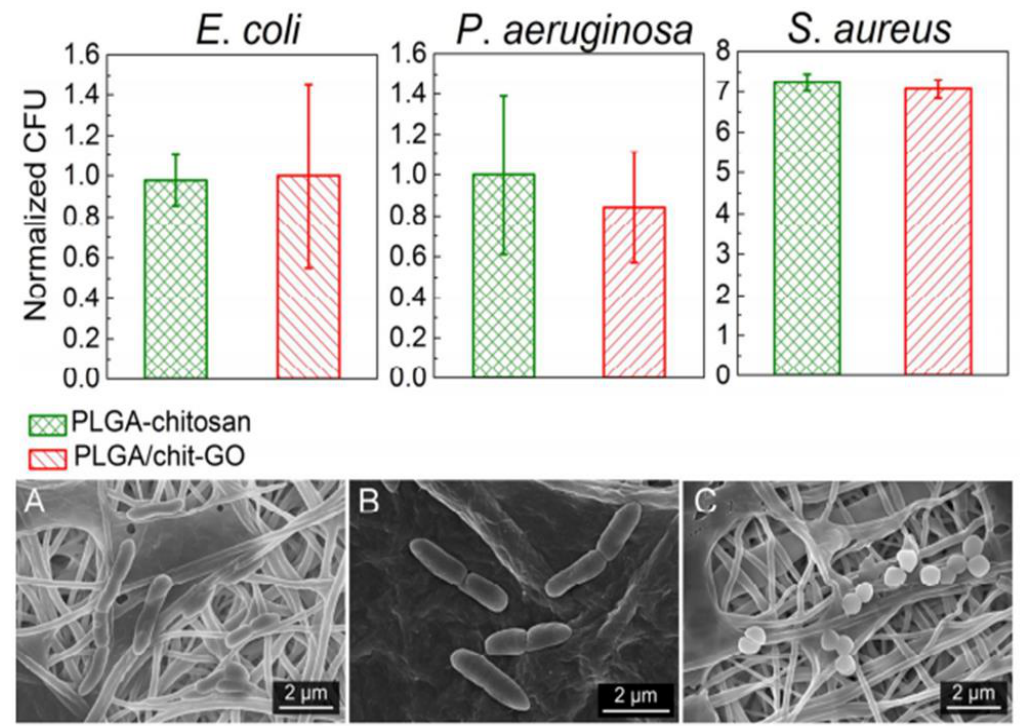
Figure 7. Top: CFU on PLGA-CS (control) and PLGA/CS-GO after exposure to E. coli, P. aeruginosa, and S. aureus . Bottom: SEM micrographs of E. coli ( A ), P. aeruginos a ( B ), and S. aureus ( C ) cells that have been exposed to the PLGA/CS-GO fiber mats. Taken from [79].